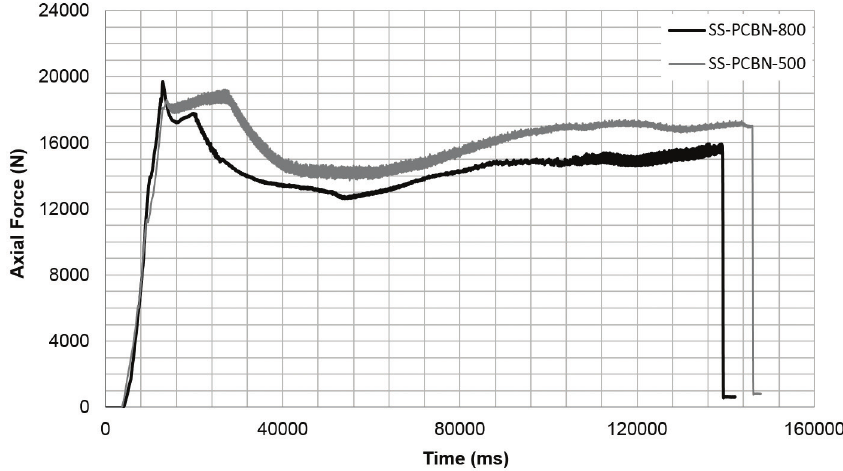
Figure 2. Profiles of axial force versus time of defect-free welded joints.